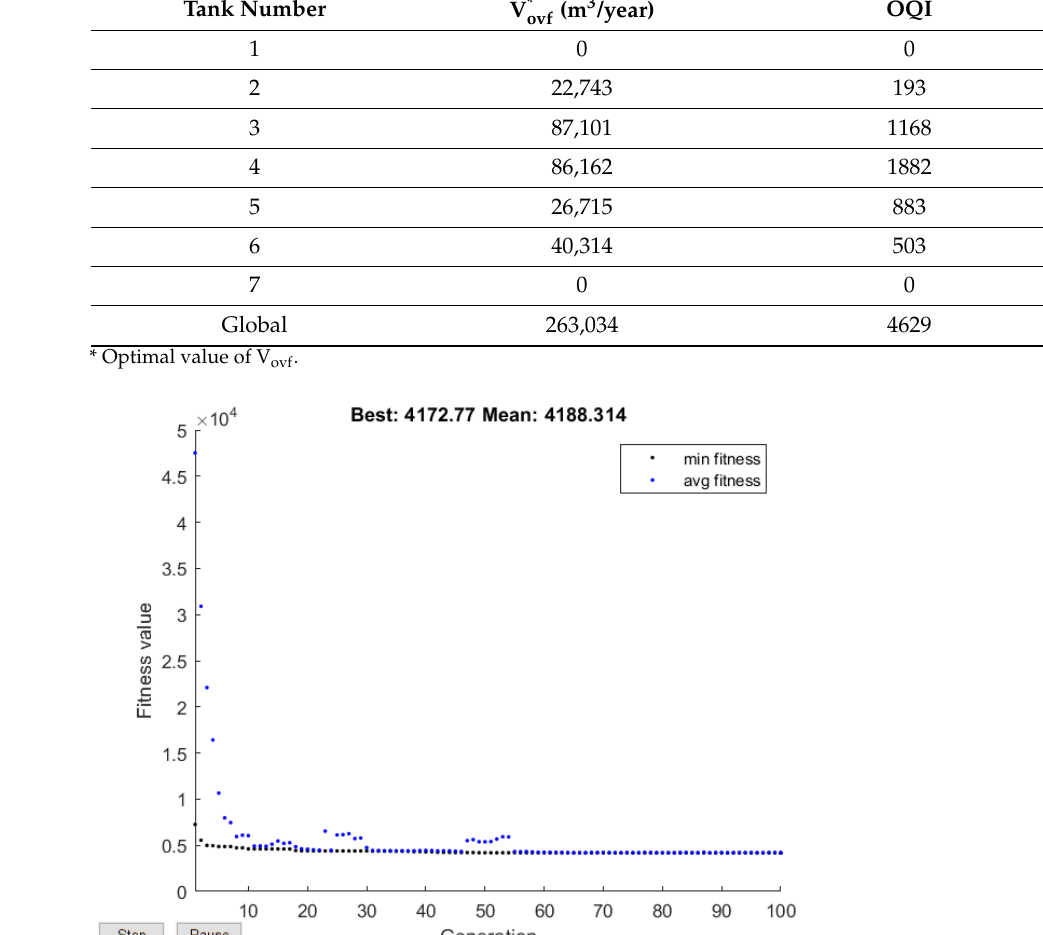
Figure 20. Best and average fitness evolution in control strategy #4 when minimizing OQI .